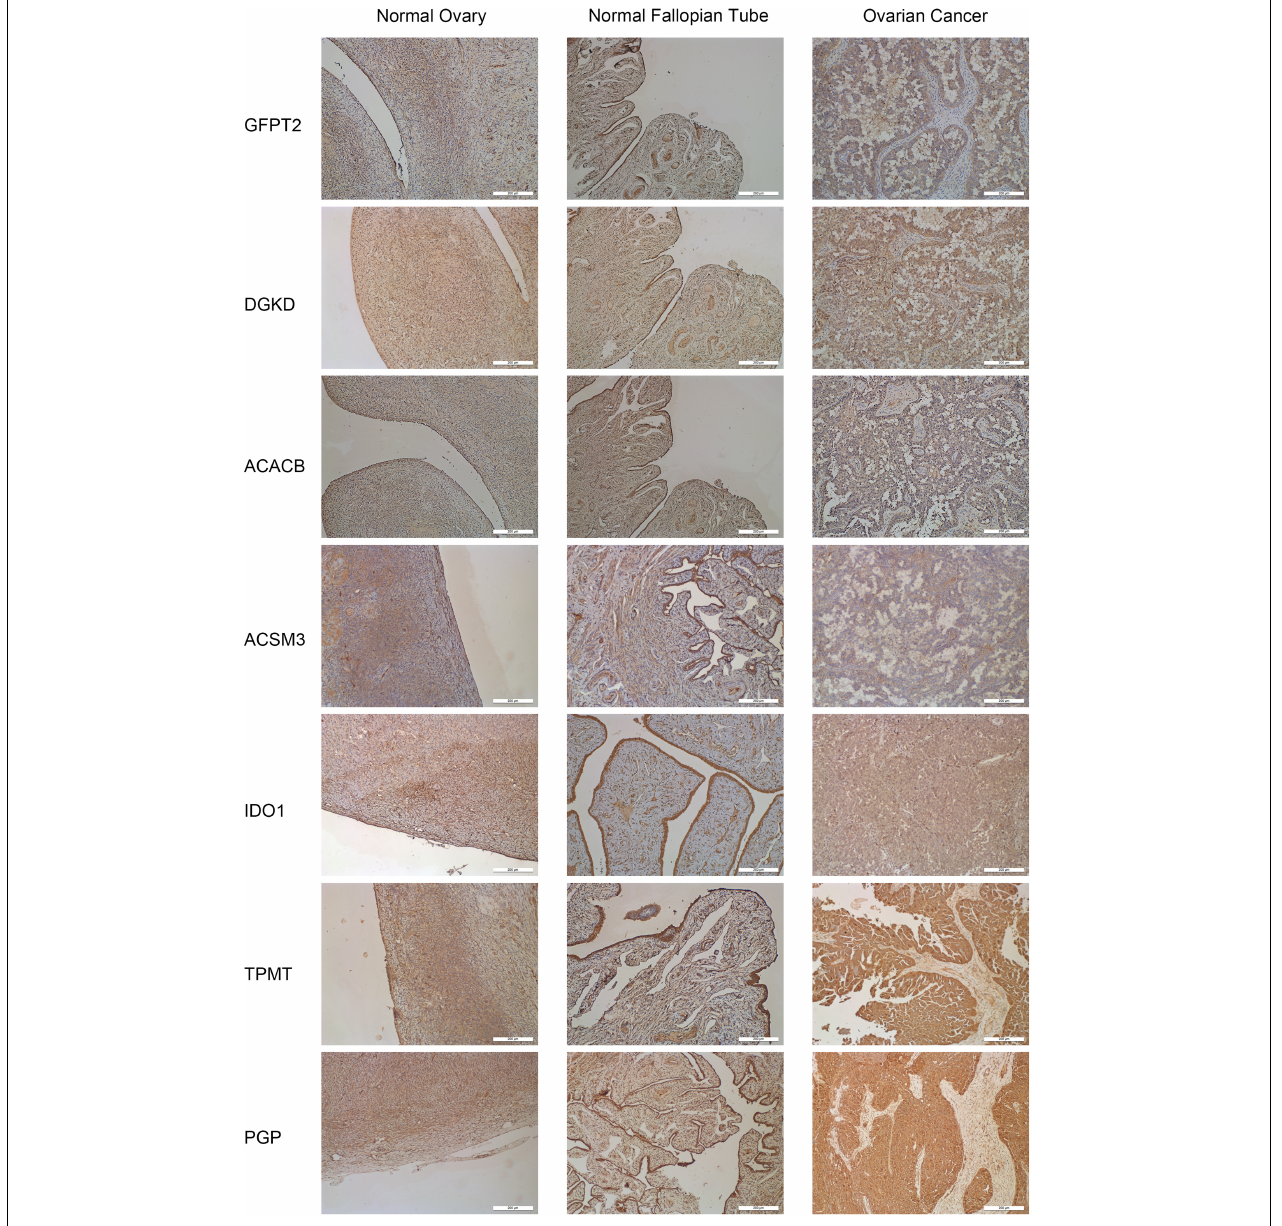
FIGURE 5 | Representative immunohistochemistry staining for seven hub genes in normal ovarian tissues, normal fallopian tube tissues, and OC tissues. The staining of IDO1, TPMT, and PGP was strong in OC tissues. Magnification ×